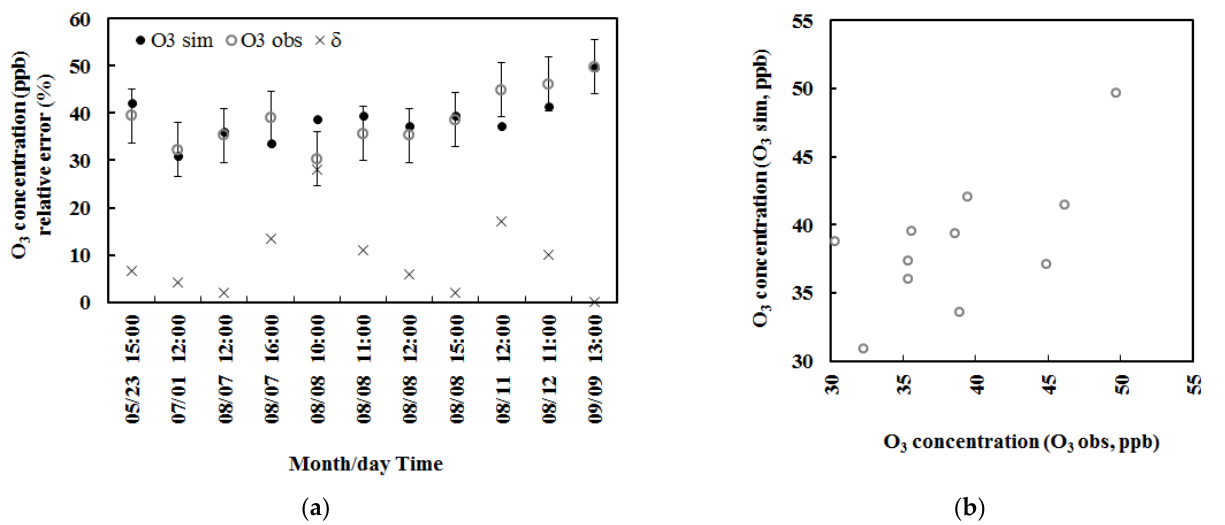
Figure 2. ( a ) Same as Figure 1a, but for considering monoterpene roles (situation B); ( b ) Same as Figure 1b, but for considering monoterpene roles (situation B).